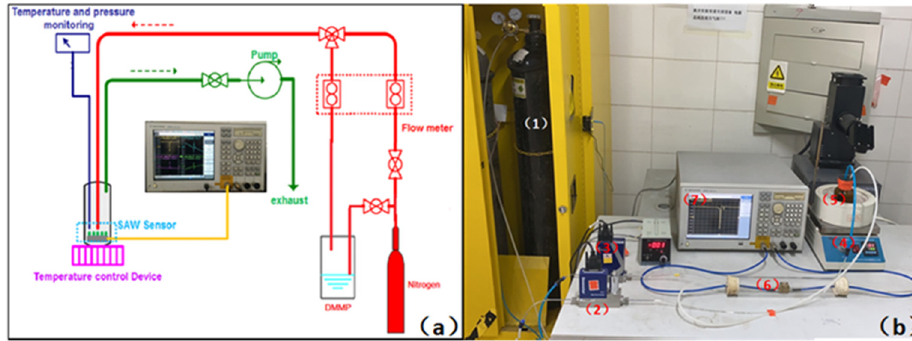
Figure 3. ( a ) Preparation process diagram of the sensing film, ( b ) DMMP measurement system.